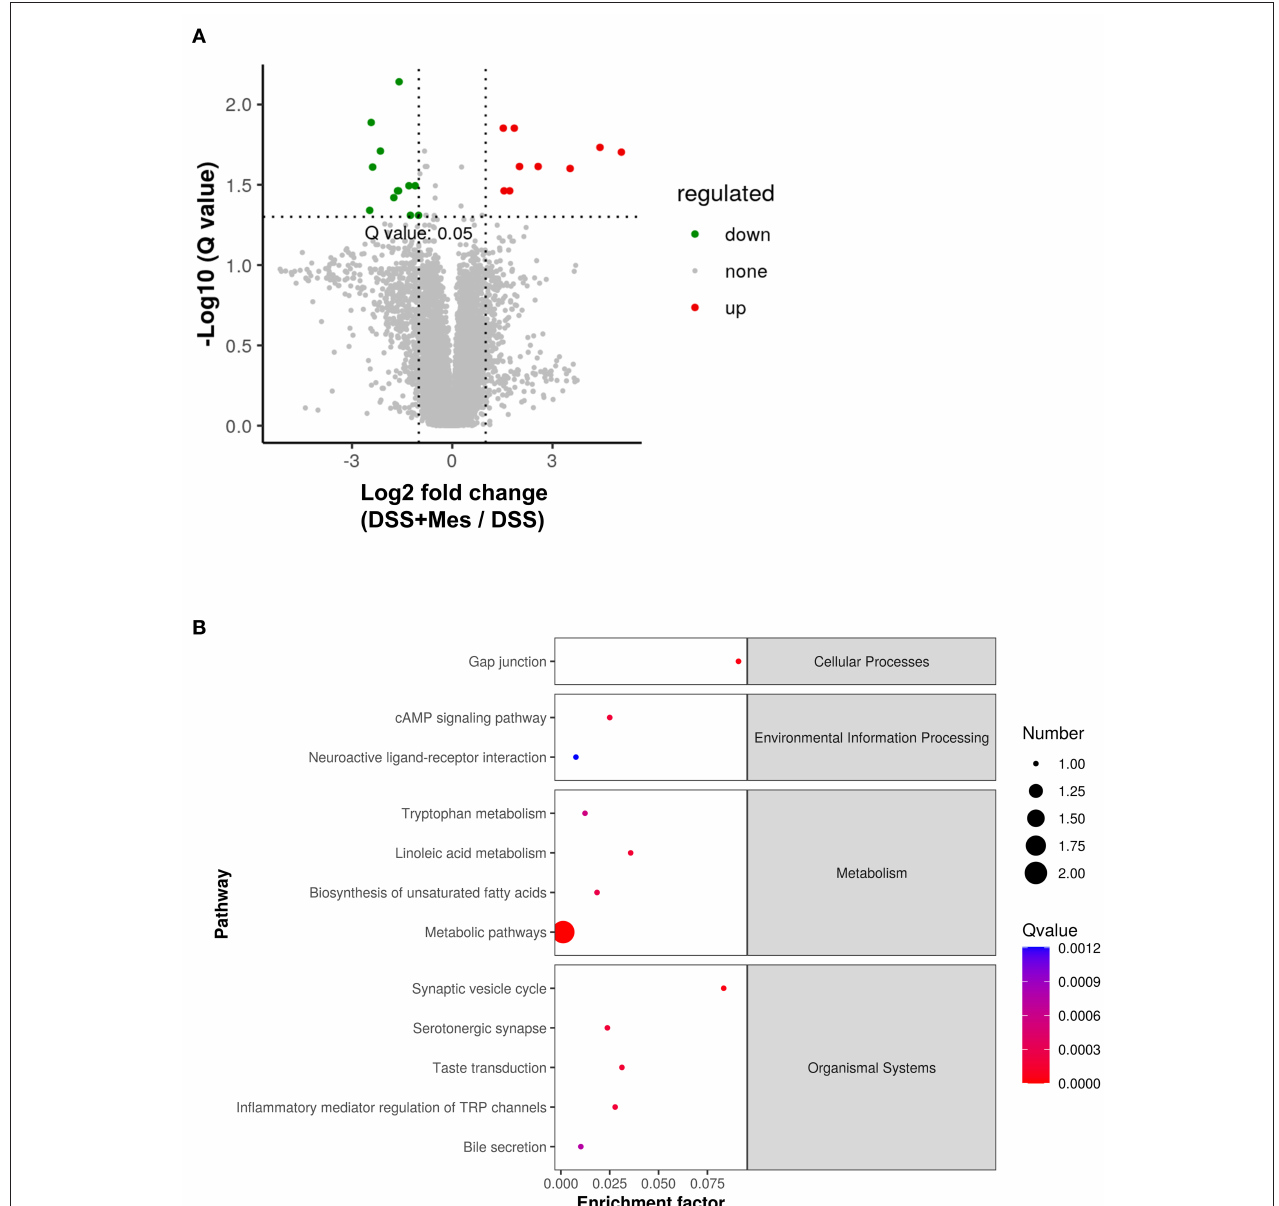
FIGURE 3 | Alteration of gut metabolites in DSS-induced UC model caused by MZ treatment. (A) Volcano plot showed the change of gut metabolites after MZ treatment in DSS-induced UC model. Green dots represented reduced metabolites. Red dots represented induced metabolites. (B) Rich factor plot showed the alteration of KEGG pathways in DSS-induced UC model caused by MZ treatment. The size of dot represented the number of gene. The color intensity of dot represented the significance of the